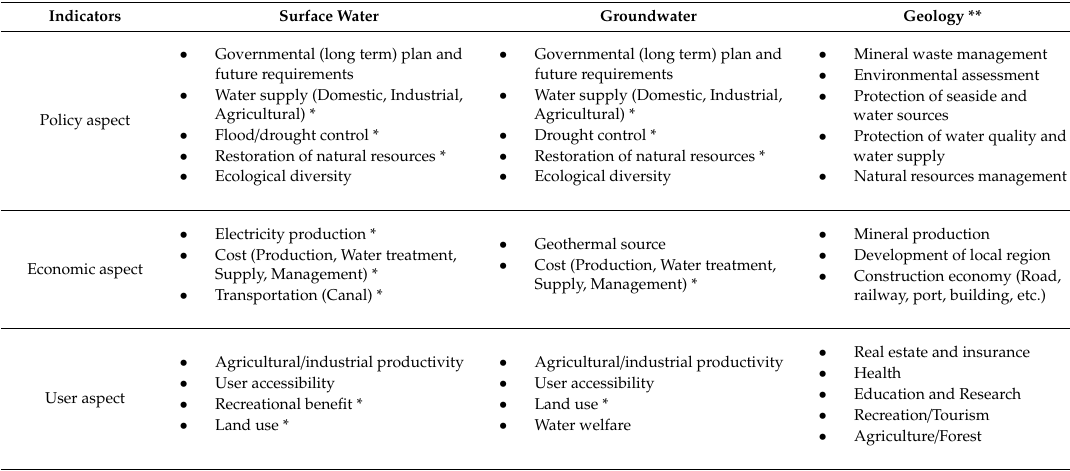
Table 3. Some selective indicators used for comparing the benefits of information in surface water, groundwater and geology